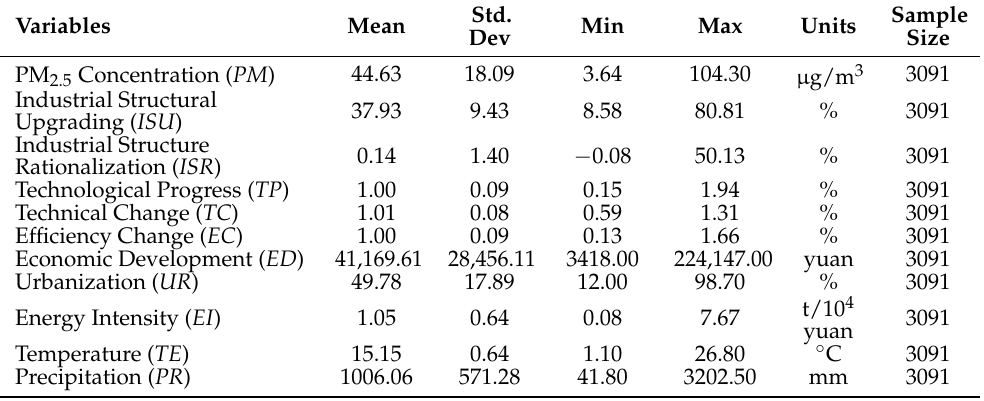
Table 1. Variable statistics results.